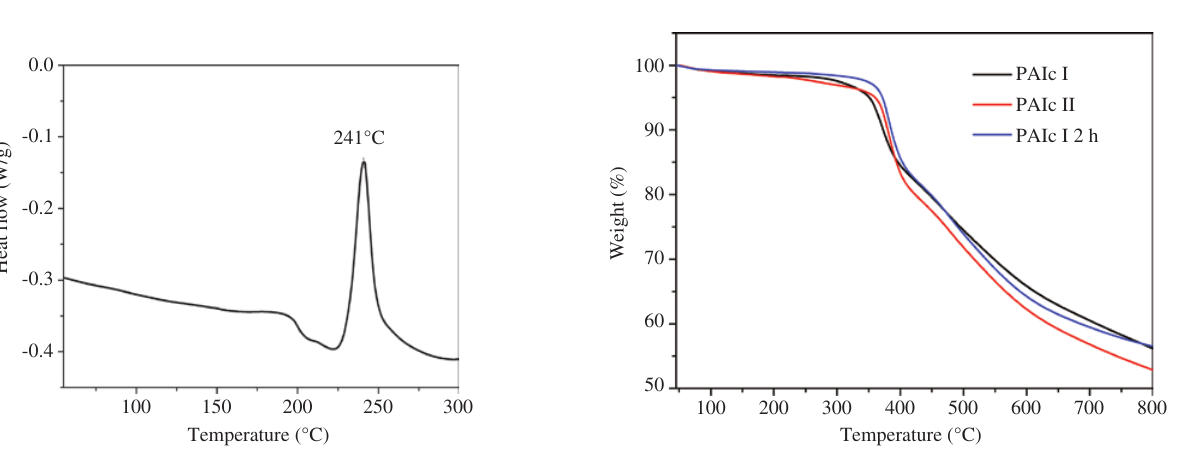
Figure 7: DSC traces of the PAIc I.